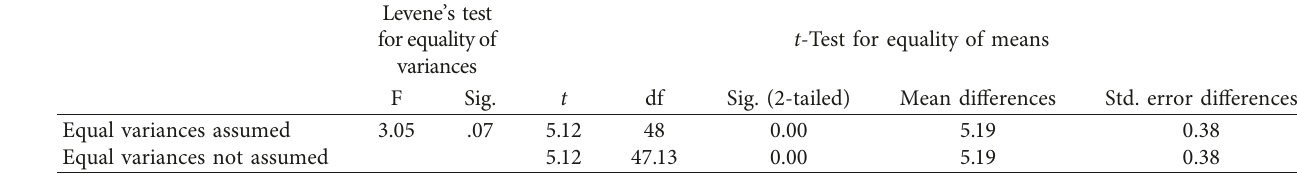
Table 9: Inferential statistics of the two groups on the motivation posttest.